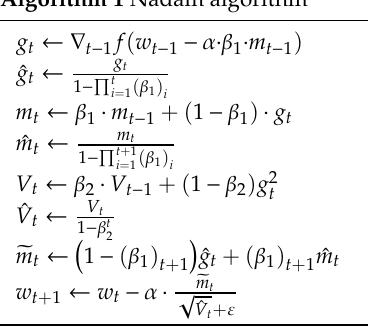
Algorithm 1 Nadam